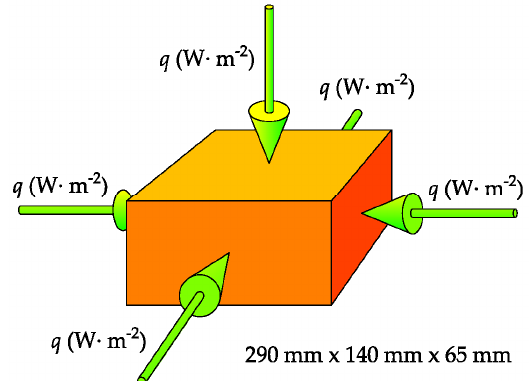
Figure 6. Scheme of the energy demands modeling procedure.